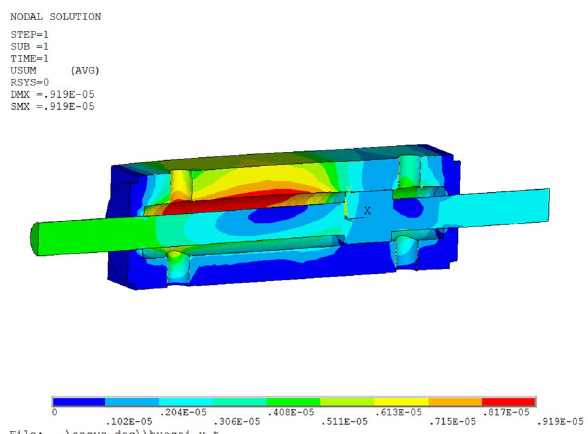
Fig. 10 Displacement variation of the plunger cylinder